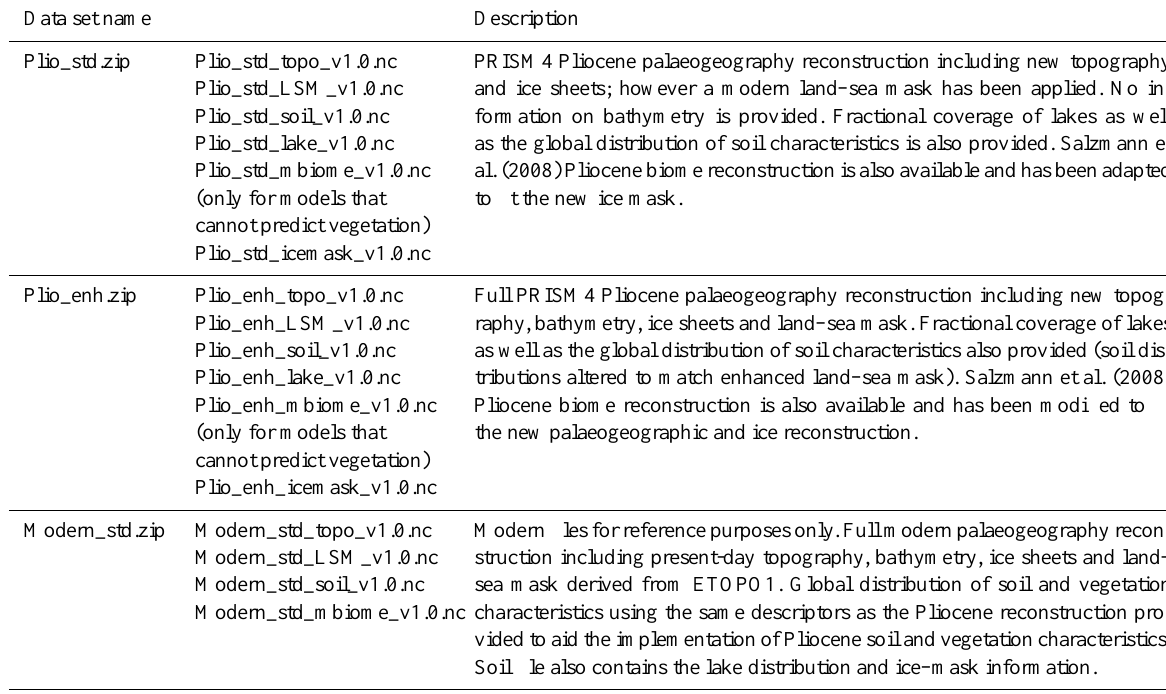
Table 1. Details of NetCDF data packages provided to facilitate PlioMIP Phase 2 experiments.